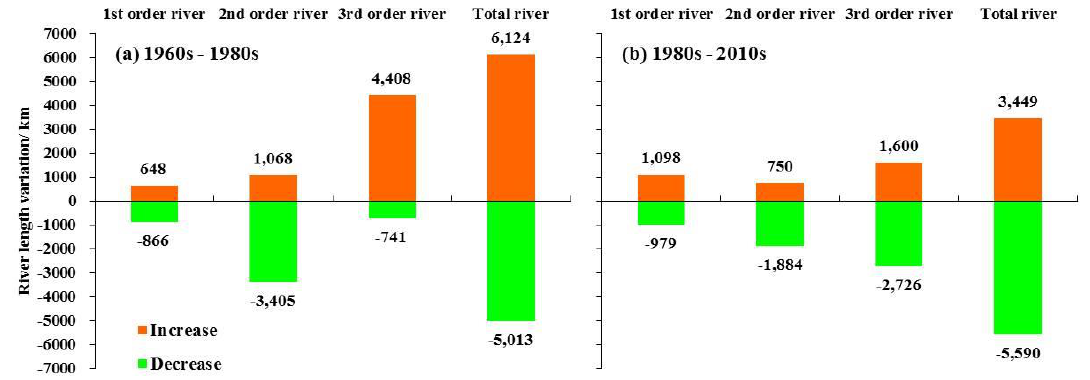
Figure 7. River length changes during the 1960s–1980s ( a ) and the 1980s–2010s ( b ), using a 3 km × 3 km grid as the basic statistical unit. Note that ( a , b ) have the same vertical